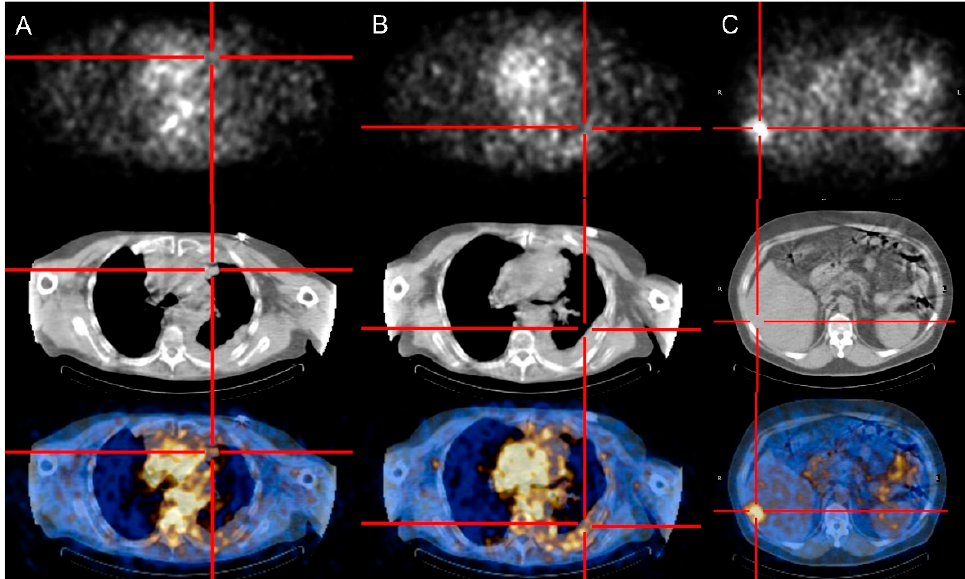
Figure 1. Patterns of Radretumab uptake at diagnostic phase. SPECT/CT images obtained 24 h post injection show absent ( A ), faint ( B ), and intense ( C ) Radretumab uptake, respectively.